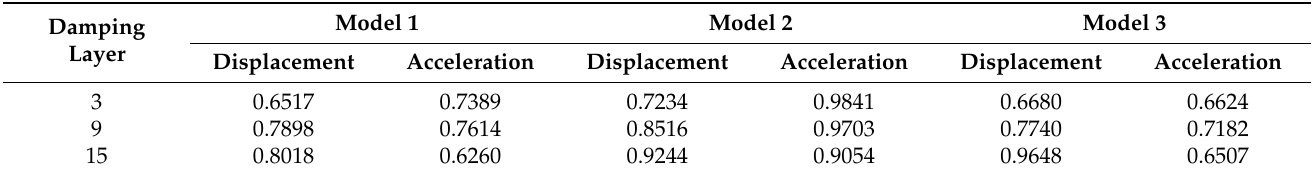
Table 2. Damping effects for the top floor response (El Centro).